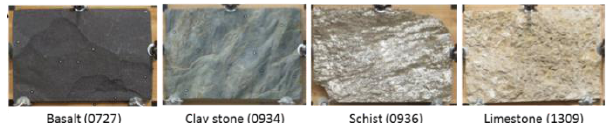
Fig. 2. Rock samples, 20 x 30 cm in plan dimensions and mounted to a wooden